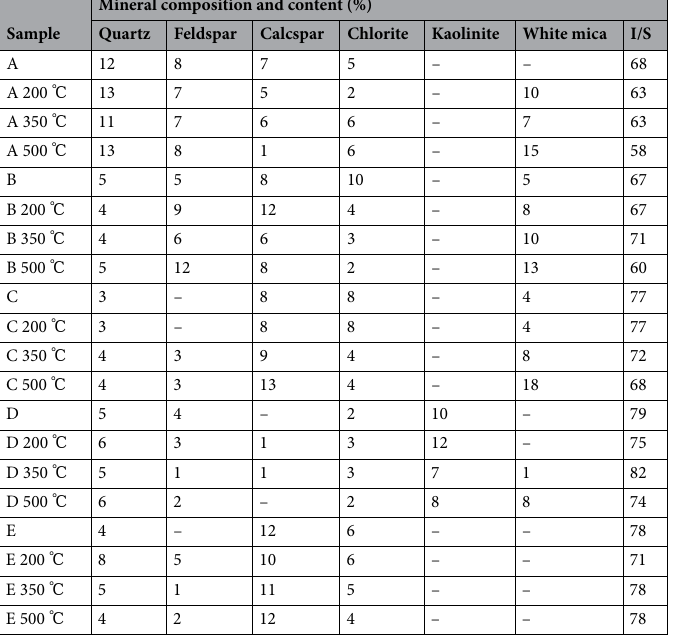
Table 1. Mineralogical composition of five samples based on X-ray diffraction (XRD) analysis. I/S illite/ montmorillonite